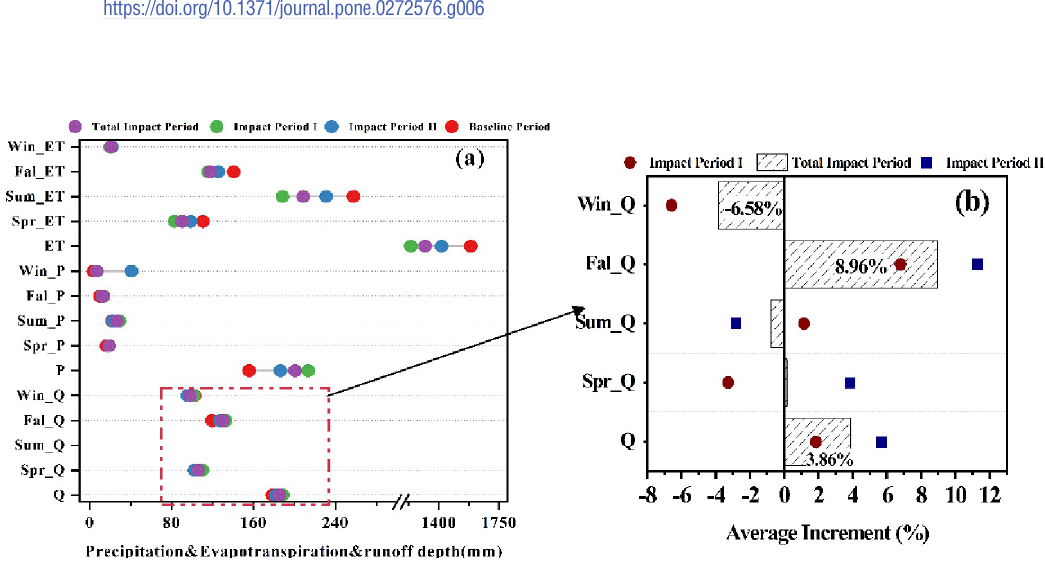
Fig 7. Comparison of average changes in hydroclimatic variables between the impact period and the base period. Where Win_ET, Fal_ET, Sum_ET, Spr_ET, ET, Win_P, Fal_P, Sum_ET, Spr_P, P, Win_Q, Fal_Q, Sum_Q, Spr_Q, Q represent the average evapotranspiration value in winter, the average evapotranspiration value in autumn, the average evapotranspiration value in summer, the average evapotranspiration value in spring, the average annual average evapotranspiration, winter average precipitation, fall average precipitation, summer average precipitation, spring average precipitation, annual average precipitation, winter average runoff, fall average runoff, summer average runoff, spring average runoff, annual average runoff.